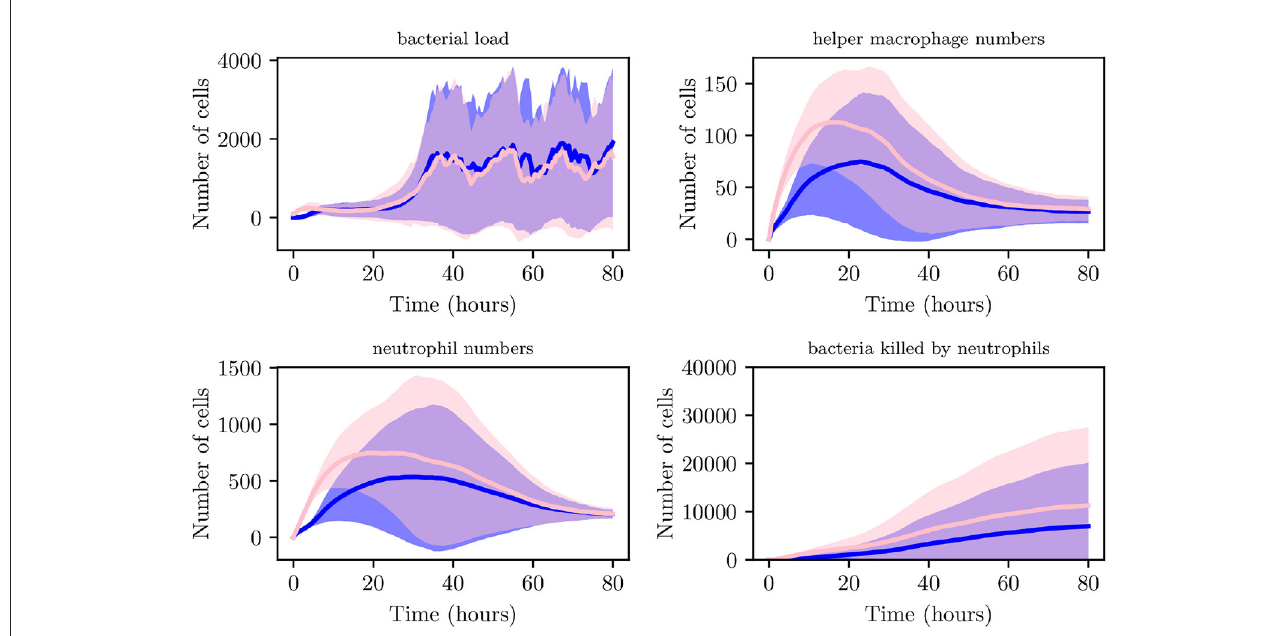
FIGURE10 Average values for bacterial load, helper macrophage load, neutrophil load and neutrophil clearance for simulations with I B = 1 (shown in blue) and for simulations with I B = 100 (shown in pink), with 95 % confidence intervals (shown by the shaded regions).